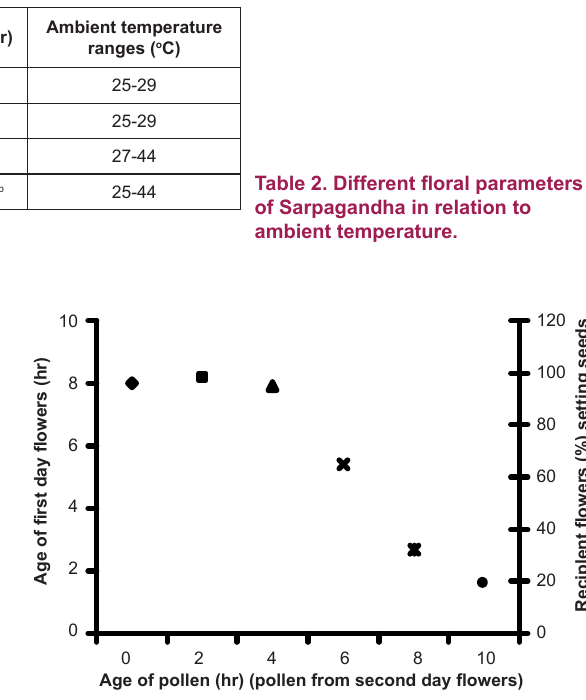
Figure 4. Level of pollen viability and/ or stigmatic receptivity (measured by per cent of flowers setting seeds) after different time duration in Sarpagandha.